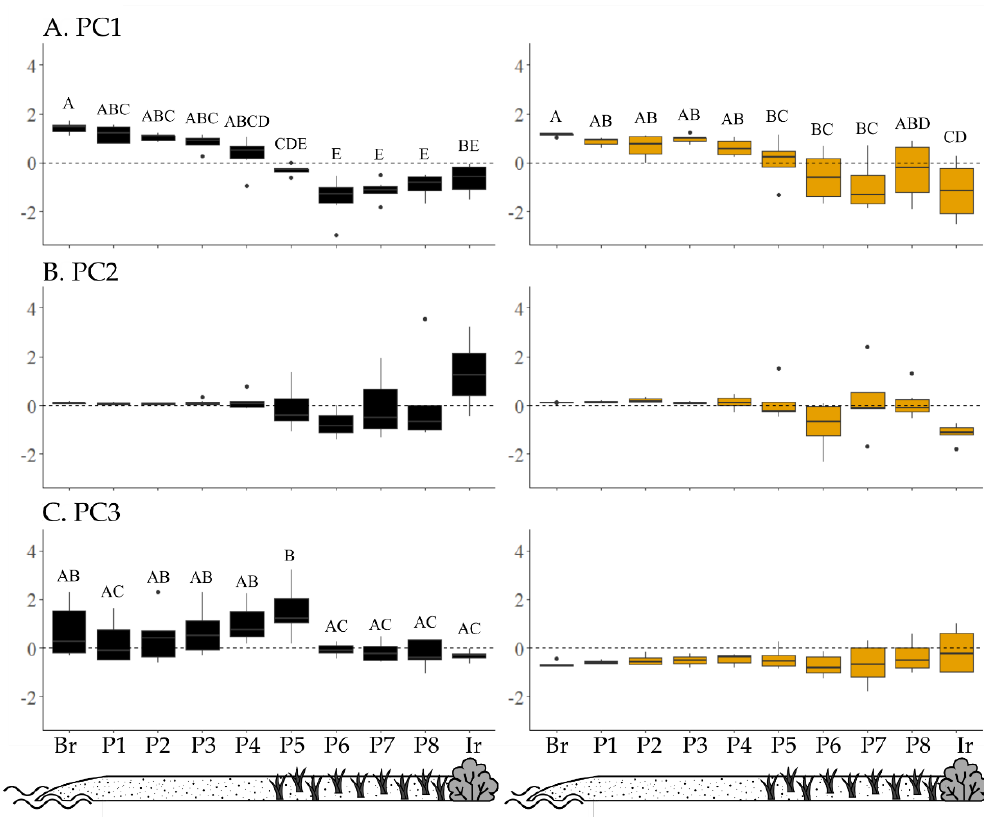
Figure 1. Principal components scores along the beach–inland transition zone. Boxplot representation for the mean PC1–PC3 scores of the beach–inland transition zones. Br: Beach reference plot; P1–P8: plot 1 to plot 8, with the first pioneering plants of the supralittoral vegetation starting between plot 4 and plot 5; Ir: Inland reference plot) of the two investigated islands (black: Dhidhdhoo, orange: Veyvah; N = 6 per island). For the loadings of the PCs, refer to Table 1. Significant differences in the PC scores of the plots of the two islands were detected for PC1—Dhidhdhoo ( p < 0.001) and Veyvah ( p < 0.001) and PC3—Dhidhdhoo ( p = 0.003). Different letters indicate significant differences ( p < 0.05) in the pairwise comparisons of the single plots (Tukey HSD post-hoc testing), same letters indicate no significant difference in PC score ( p > 0.05).